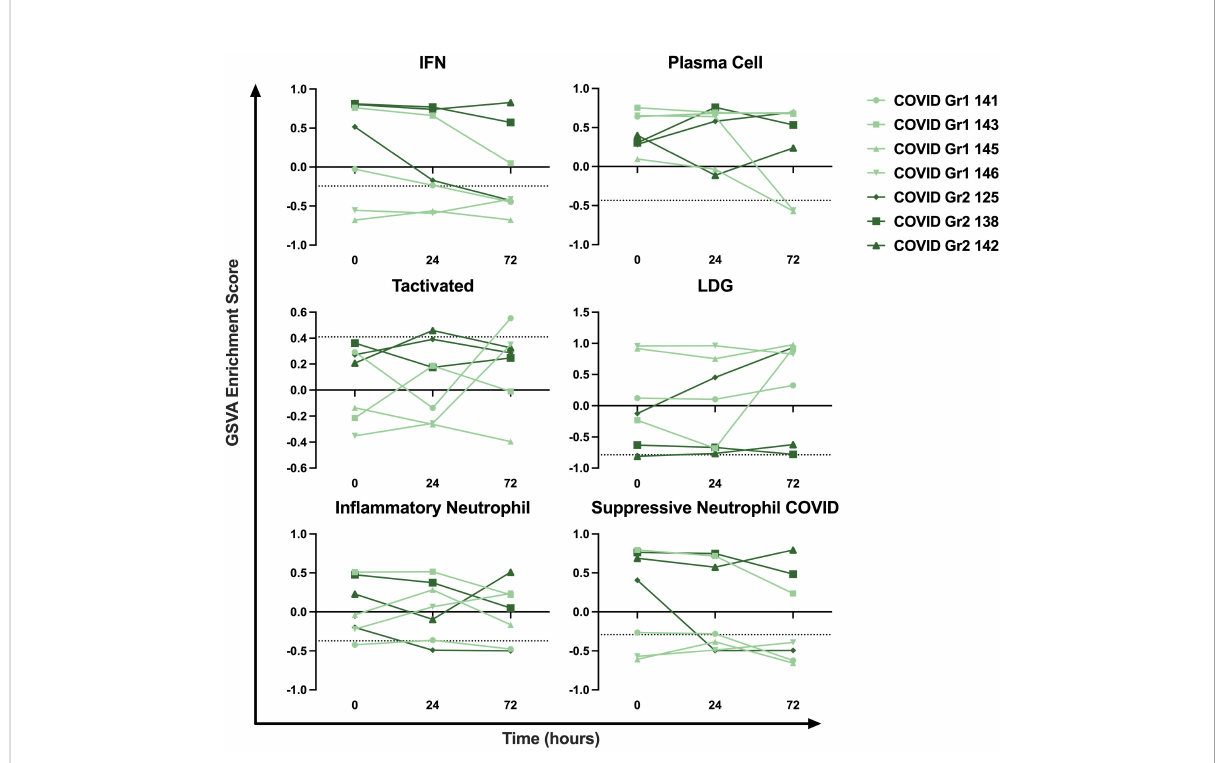
FIGURE 6 Longitudinal sampling reveals persistence of immune cell and pathway gene signatures over time. Trajectory plots of select immune cell and pathway GSVA enrichment scores from individual COVID-19 ICU patients at baseline, 24 hours, and 72 hours